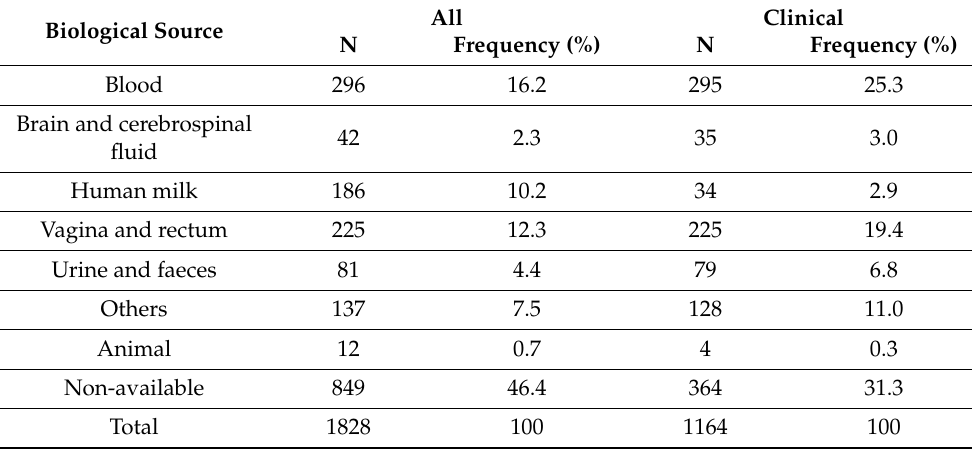
Table 3. Distribution of S. agalactiae sequences in NPDIB by biological source. Biological